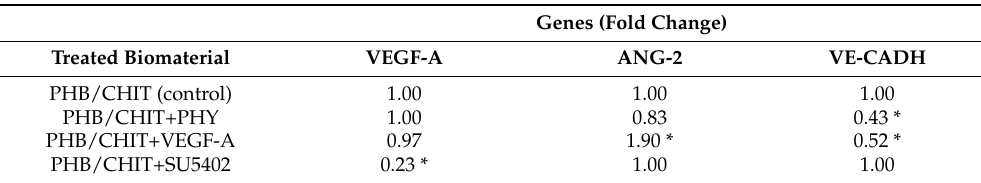
Table 5. Relative gene expression from RT-qPCR analysis for genes VEGF-A, ANG-2, and VE-CADH. Experimental groups included five samples of the scaffolds for each group.